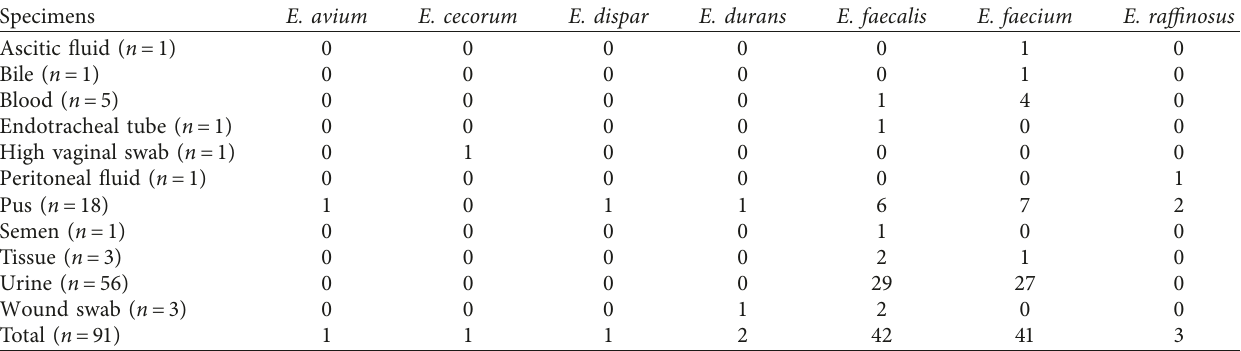
Table 2: Distribution of Enterococcus species in various clinical specimens.